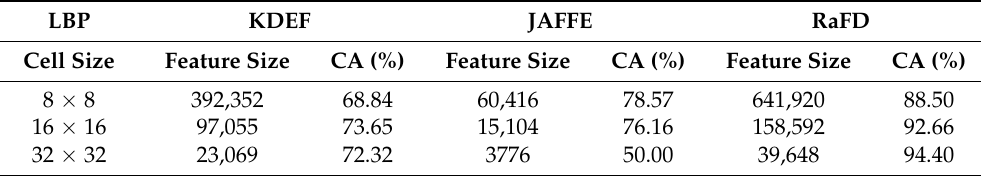
Table 2. Classification accuracy and feature size with LBP method applied to the original image